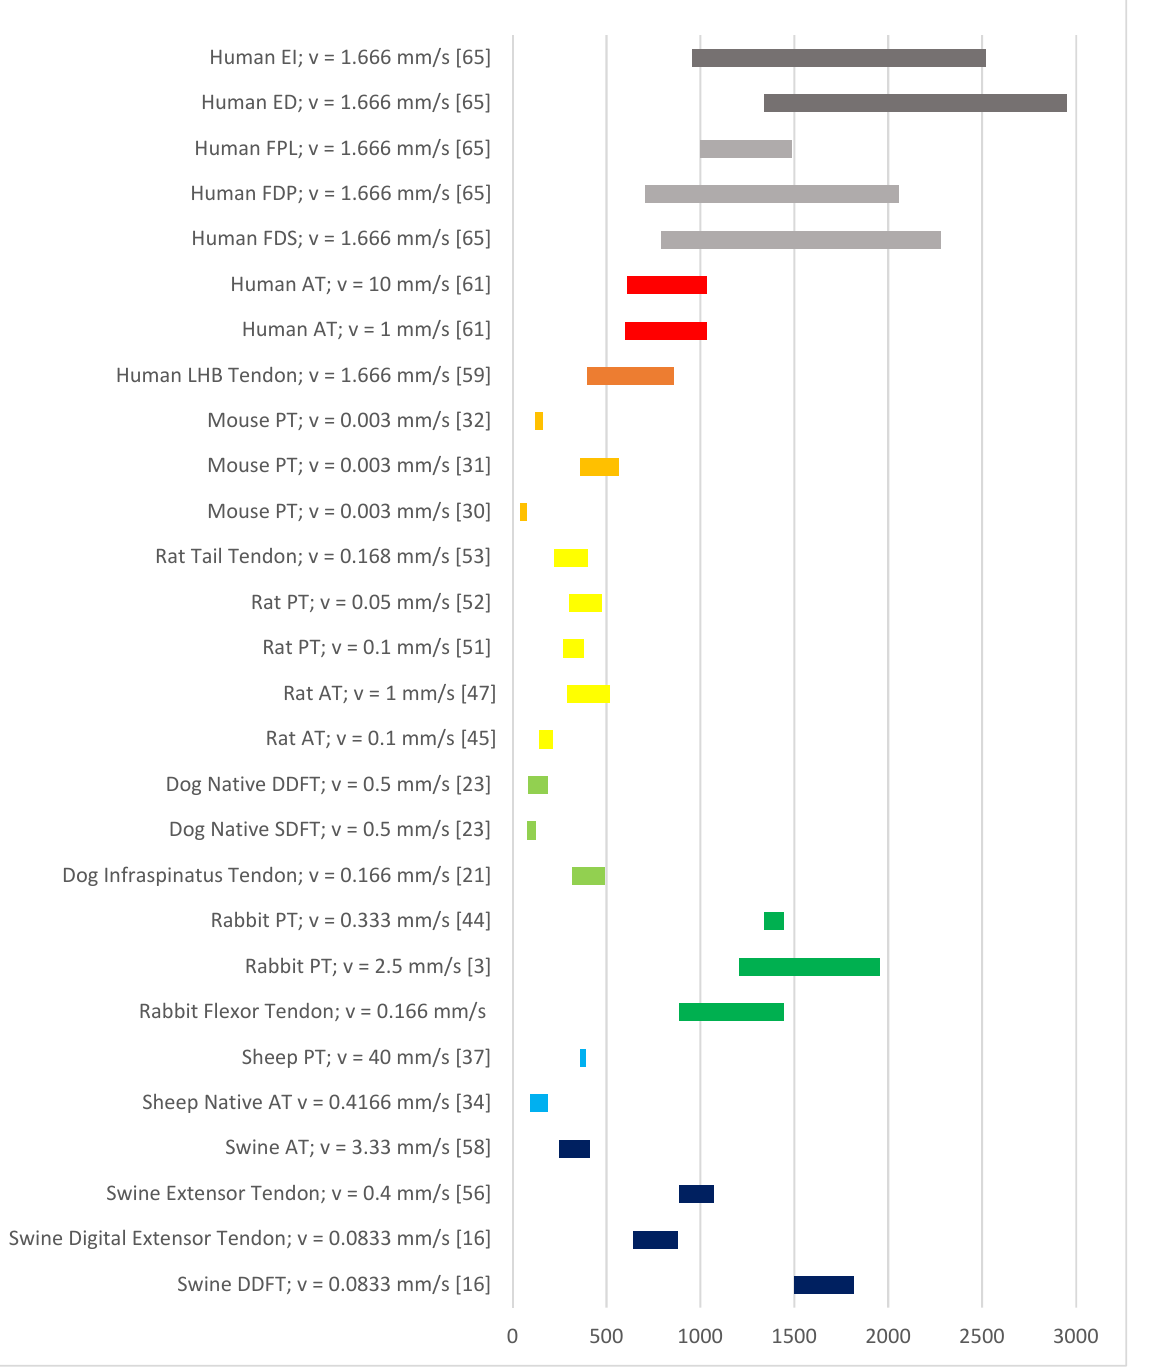
Figure 2 . Young’s modulus for the considered animal species (mm/s). Figure 2. Young’s modulus for the considered animal species